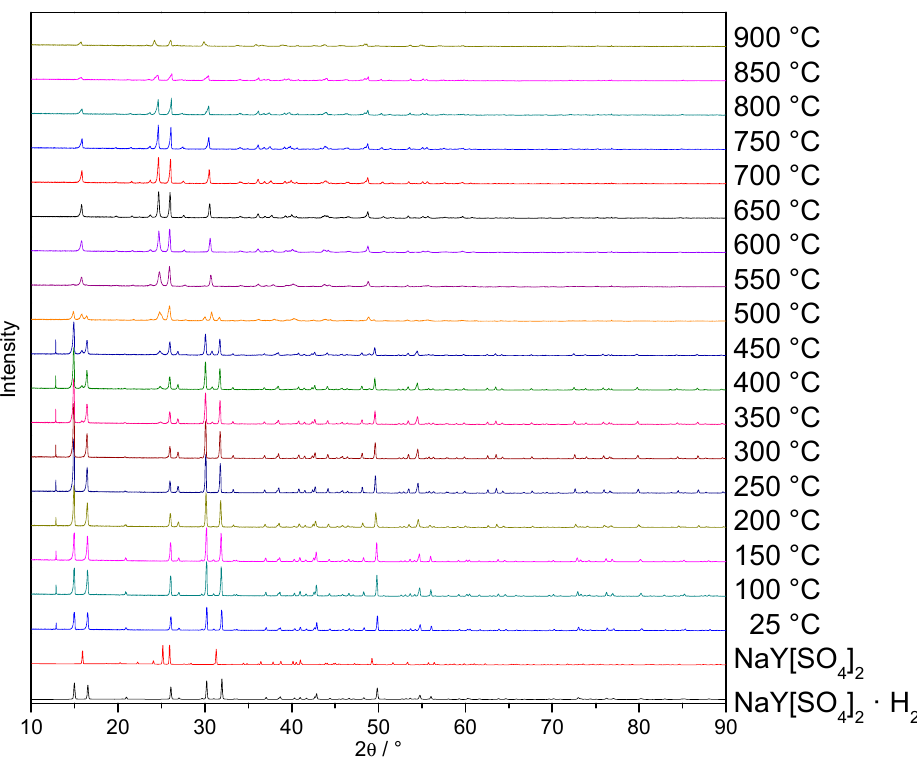
Figure 10. Temperature-dependent PXRD data of NaY[SO 4 ] 2 ∙ H 2 O in the range from 25 to 900 °C measured with Cu-K α radiation ( λ = 154.06 pm) in a reflection setting.